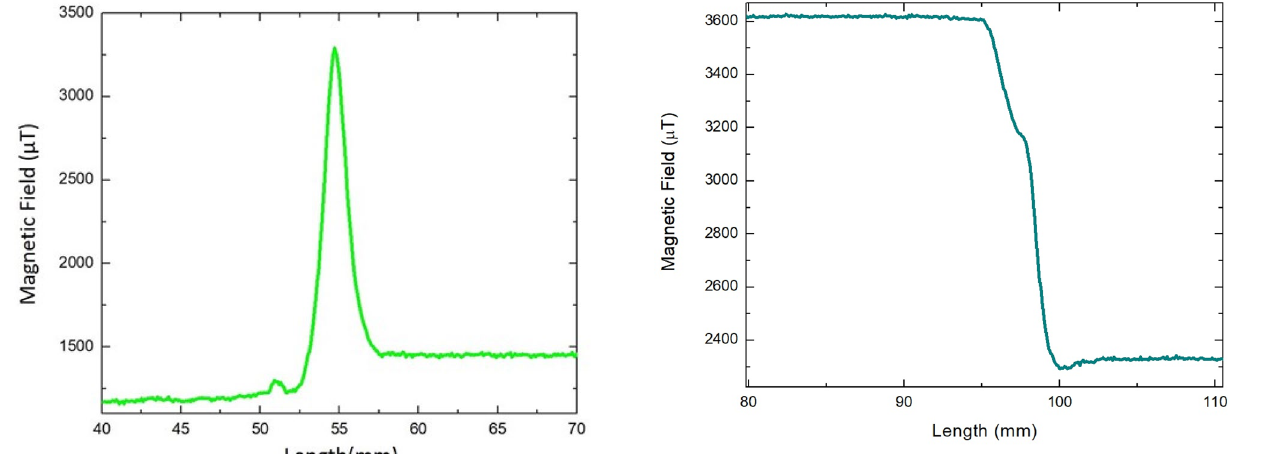
Fig. 15 Experimental result of magnetic field Z of a rectangular defect A1 with ordered magnetic domains